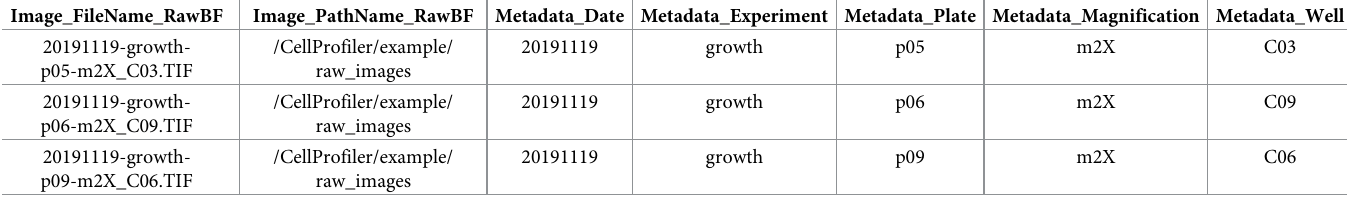
Table 1. Suggested naming conventions for CellProfiler metadata.